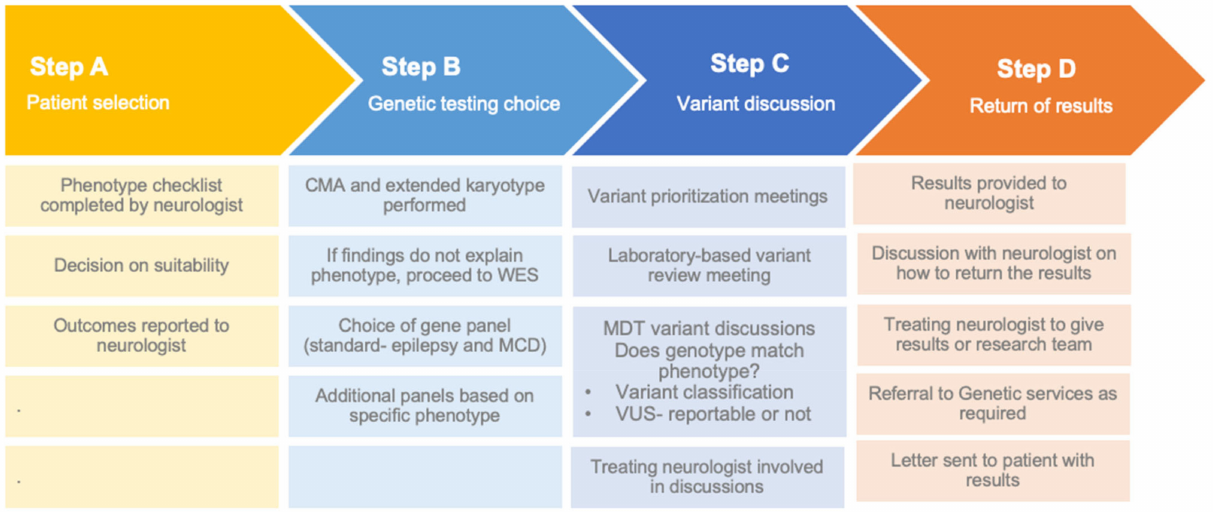
Figure 1. Steps in the multi-disciplinary approach to genomic testing. CMA—chromosomal microar- ray; WES—whole exome sequencing; MCD—malformations of cortical development; MDT—multi- disciplinary